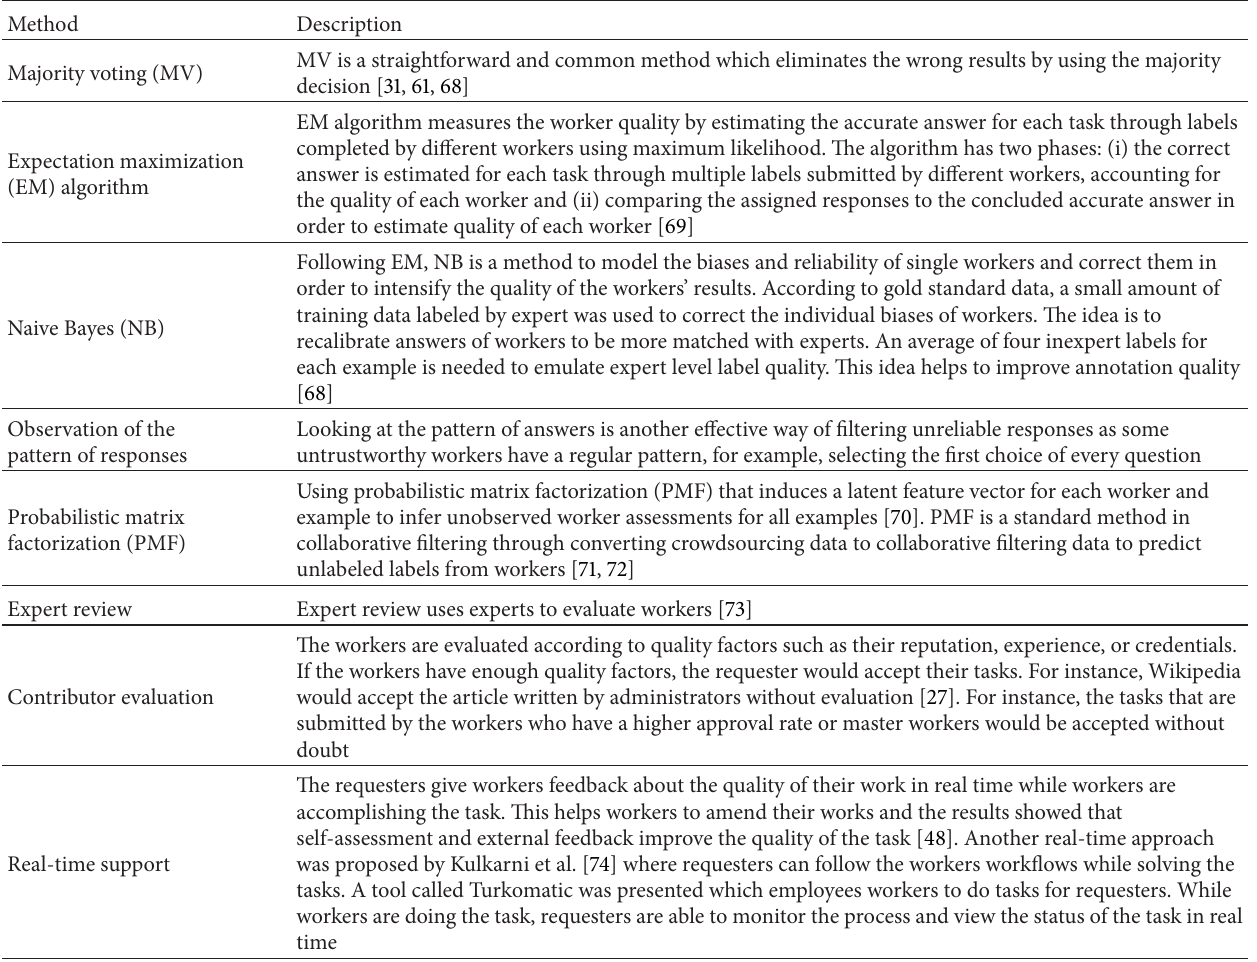
Table 7: Run-time